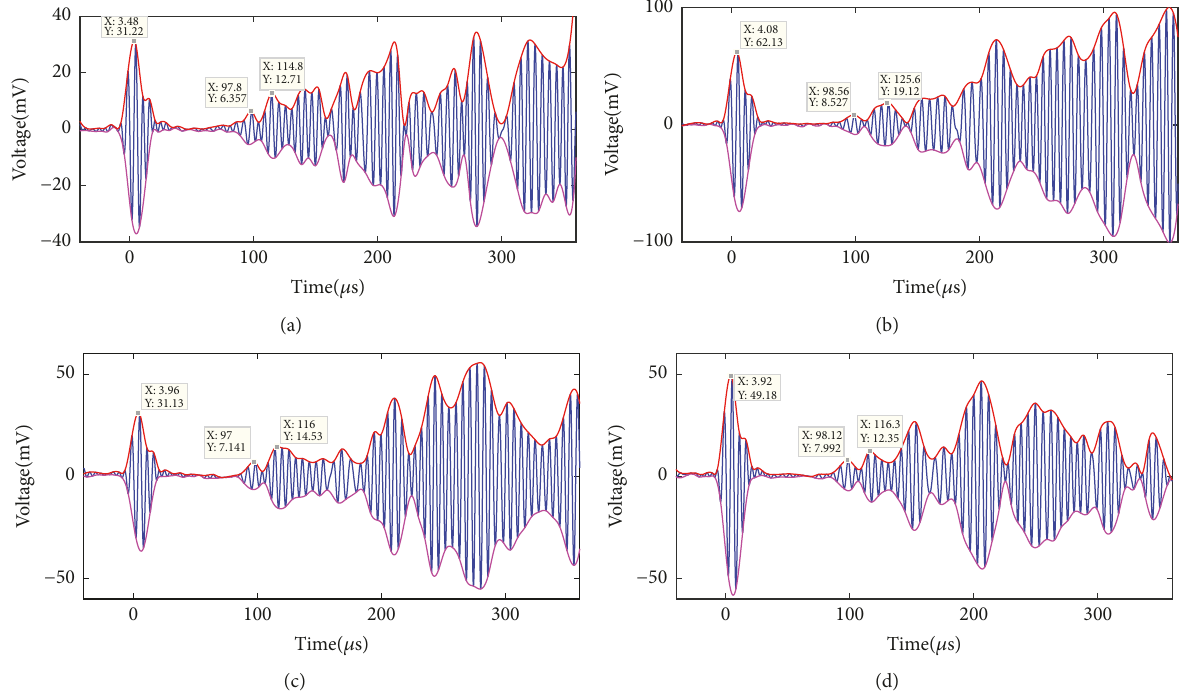
Figure 13: Collected signals of piezoelectric transducers after filtering (a) no. 1, (b) no. 2, (c) no. 3, and (d) no. 4 when the cracked rotor rotates at 15Hz.